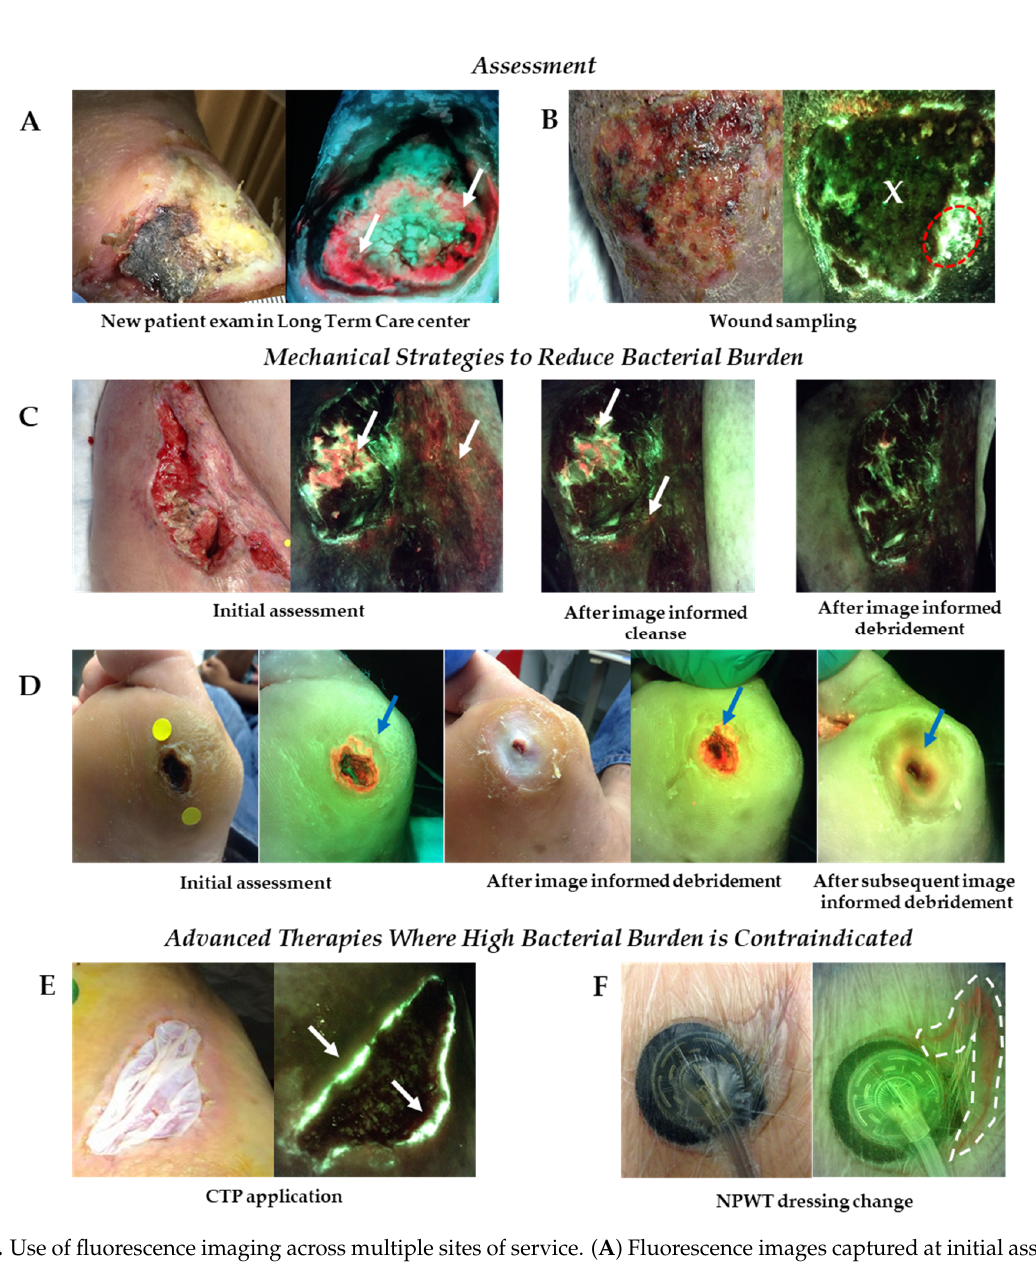
Figure 3. Use of fluorescence imaging across multiple sites of service. ( A ) Fluorescence images captured at initial assessment of a patient in long term care with a diabetic foot ulcer revealed significant bacterial burden around the wound (white arrows) that changed the plan of treatment put in place for this patient. ( B ) Images of a venous leg ulcer prompted clinician to collect wound biopsy from region of cyan fluorescence (denoted by red dotted circle), rather than the wound center (denoted by an ‘X’); sample was positive for Pseudomonas aeruginosa. ( C ) Patient with an incisional hip wound following surgery had red fluorescence (white arrows) from bacteria in and around wound. The wound was washed vigorously (HOCL cleanser) and re-imaged. Persistence of red fluorescence prompted additional cleansing and debridement in regions of red fluorescence. Red fluorescence diminished after image-informed mechanical strategies. ( D ) Red fluorescence from bacteria was detected in a diabetic foot ulcer, highlighted by blue arrow, prompting debridement. Initial debridement revealed a larger amount of bright red fluorescence in the callus tissue surrounding the wound. Additional debridement was performed to remove bacteria laden tissue. ( E ) A diabetic foot ulcer that had previously received multiple CTP applications underwent fluorescence imaging prior to application of another CTP. Images revealed the presence of cyan fluorescence (white arrows) indicative of Pseudomonas aeruginosa around the wound edge; CTP application was withheld until cyan signal was eliminated. ( F ) NPWT was applied to an appendectomy abscess. Fluorescence images were captured during a dressing change and indicated presence of red fluorescence around the wound (denoted by dashed white dotted line). Imaging informed mechanical bacterial removal prior to placement of a new dressing. CTP, cellular tissue product; NPWT, negative pressure wound therapy.